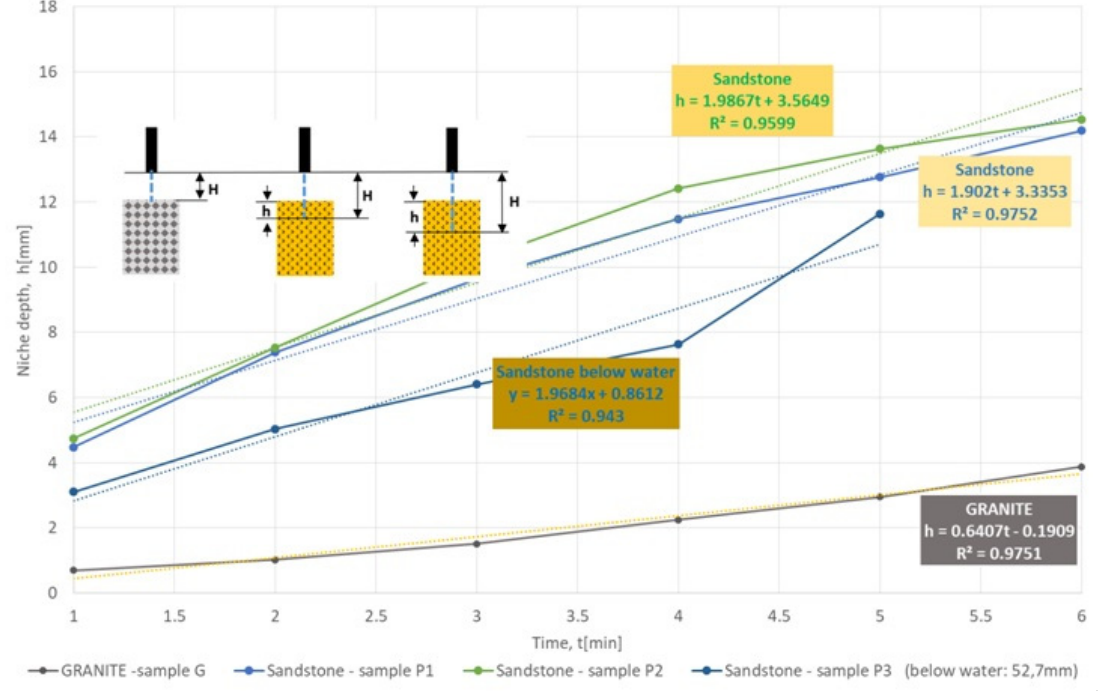
Figure 13. Average depth of cut niche as a function of water cutting time—granite and sandstone. Nozzle’s displacement velocity v = 100 (mm / min). Water jet pressure p = 500